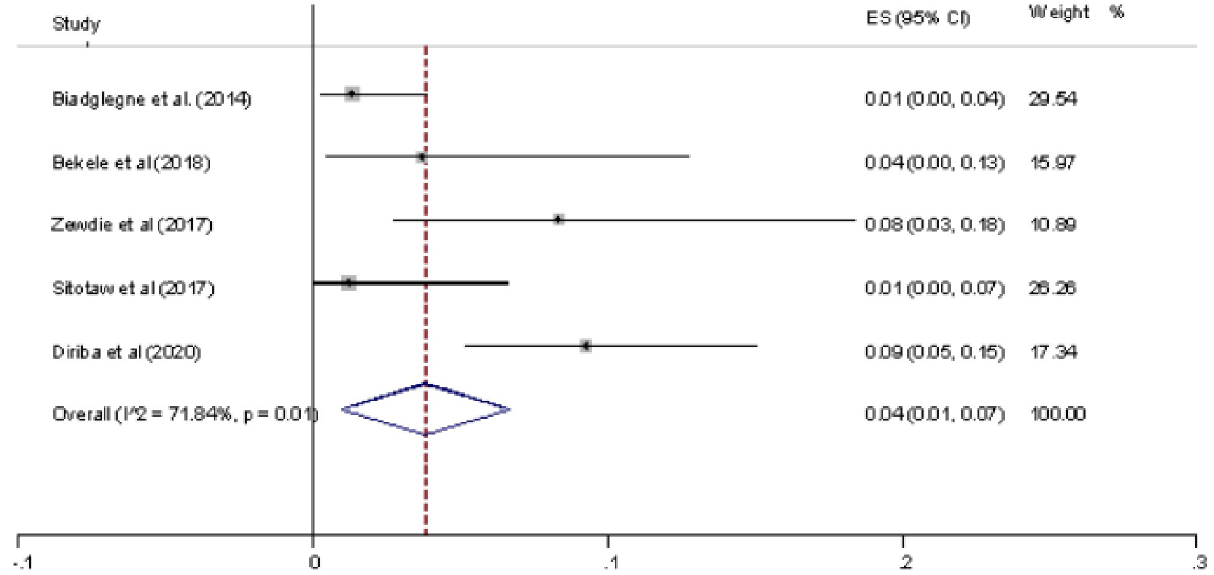
Fig 4. Forest plot showing the prevalence of MDR-TB among the total sample (EPTB) case (the pooled estimate from the random-effects model).